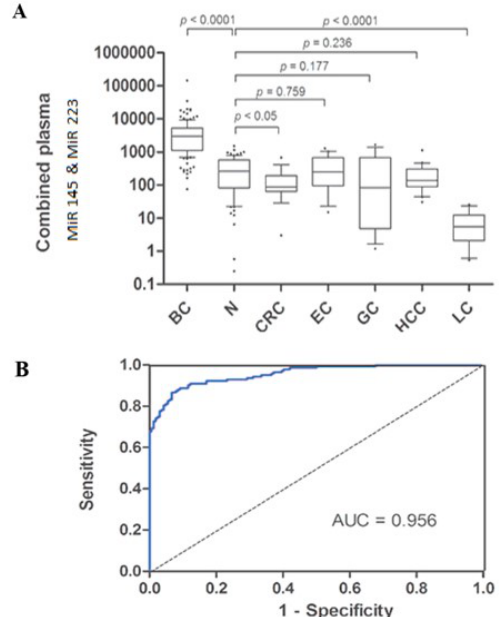
Fig. 5. Validation of combined plasma miR-145 and miR223. (A) Box plot of combined plasma miR-145 and miR-223 in patients with breast cancer (BC), healthy, normal (N), colorectal cancer (CRC), esophagus cancer (EC), gastric cancer (GC), hepatocellular carcinoma (HCC) and lung cancer (LC). B) ROC analysis using combined plasma miR- 223 and miR-145 for discriminating breast cancer from normal subjects and other